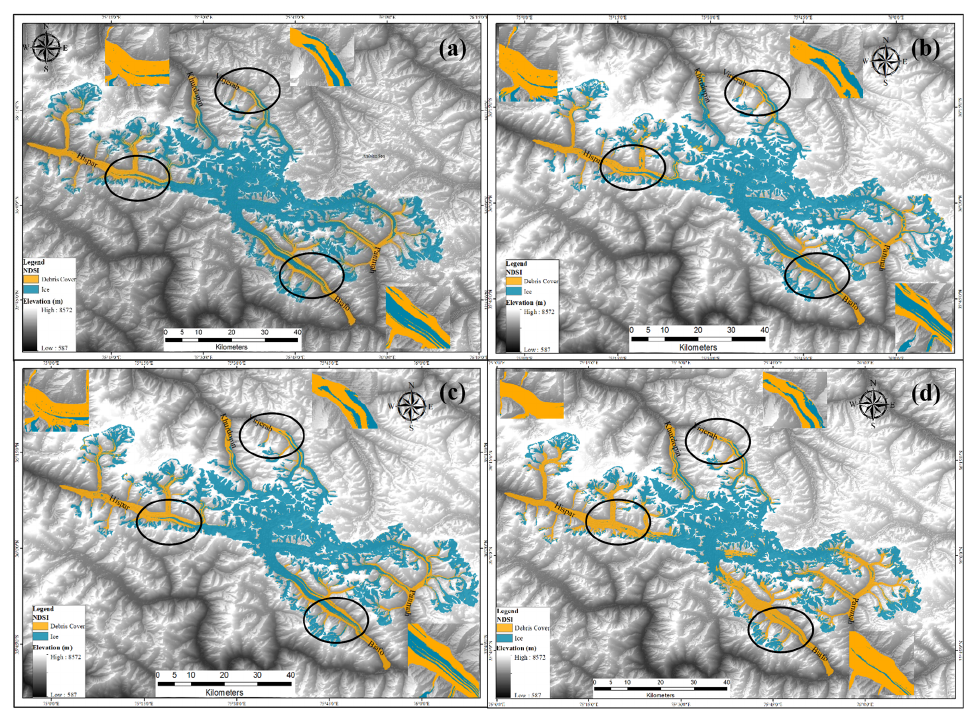
Figure 7. Glacier inventory of Central Karakoram National Park (CKNP) overlaid on ASTER 30-m DEM; ( a ) 1990, ( b ) 2001, ( c ) 2009, and ( d ) 2020. The yellow color shows debris-covered ice and the blue color shows clean ice. Encircled areas show the temporal variations in ice and debris-covered ice from 1990–2020 at various spots.